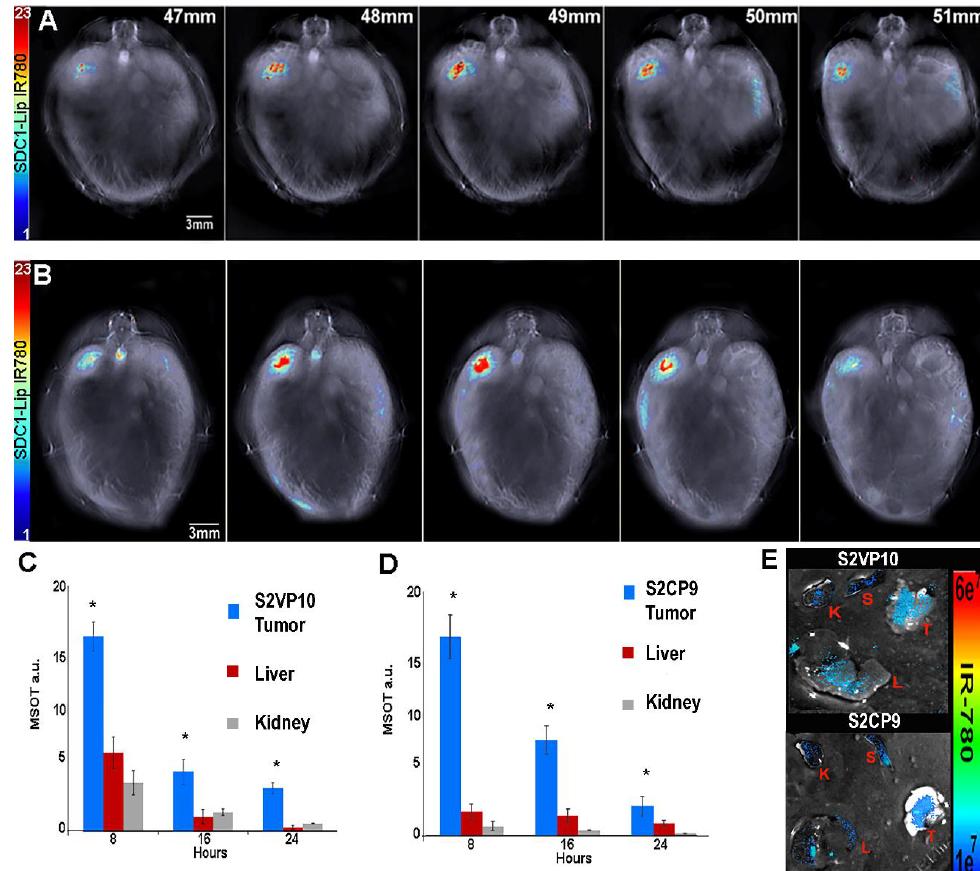
Figure 5. Biodistribution of SDC1-Lip in orthotopic pancreatic tumor models using multispectral optoacoustictomography(MSOT).BiodistributionofSDC1-LipwasassessedusingMSOTin( A )